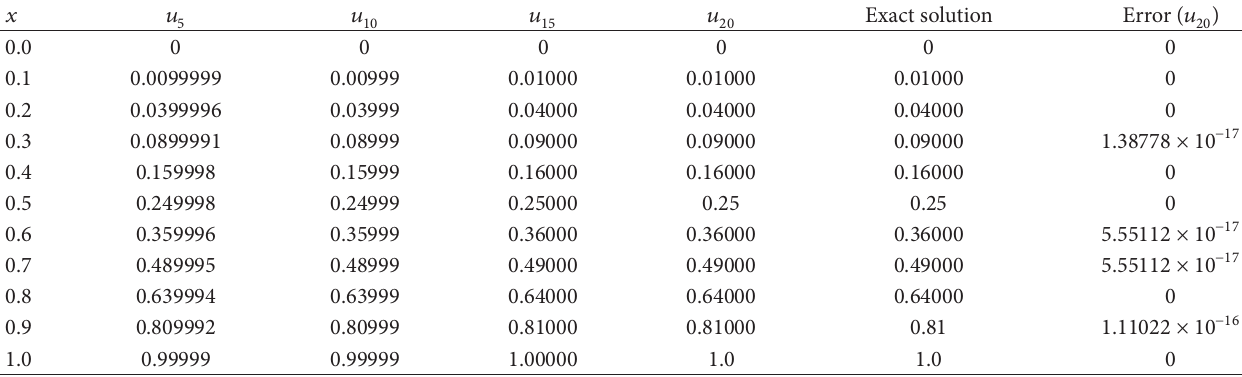
Table 4: Numerical result of Example